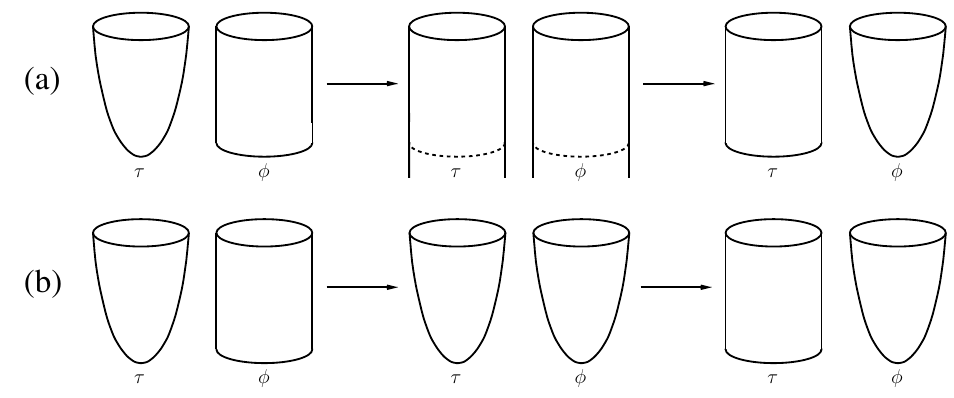
Figure 4 . Possible “interpolations” between the deconfined and confined geometries in figure 1. Top row (a): interpolation through the ( cy, cy ) geometry. Bottom row (b): interpolation through the ( ci, ci )